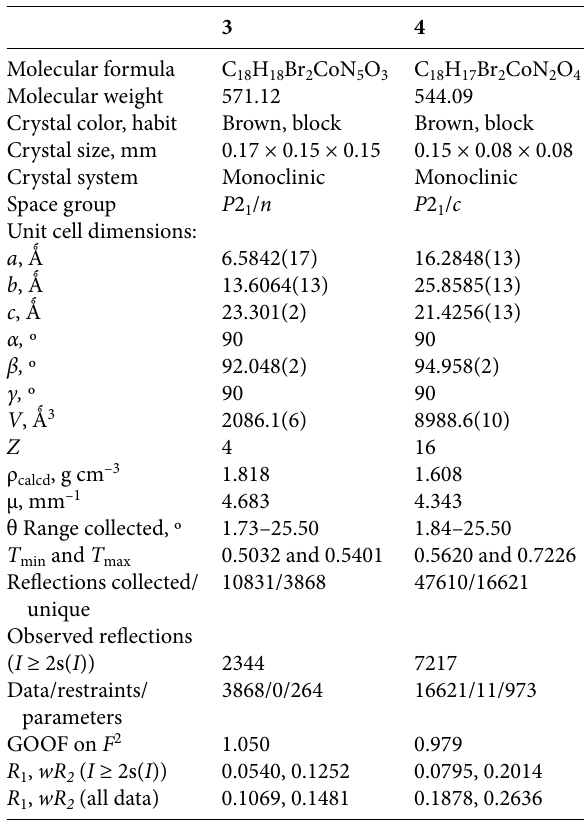
Table 1a. Crystallographic data and refinement details for the zinc complexes